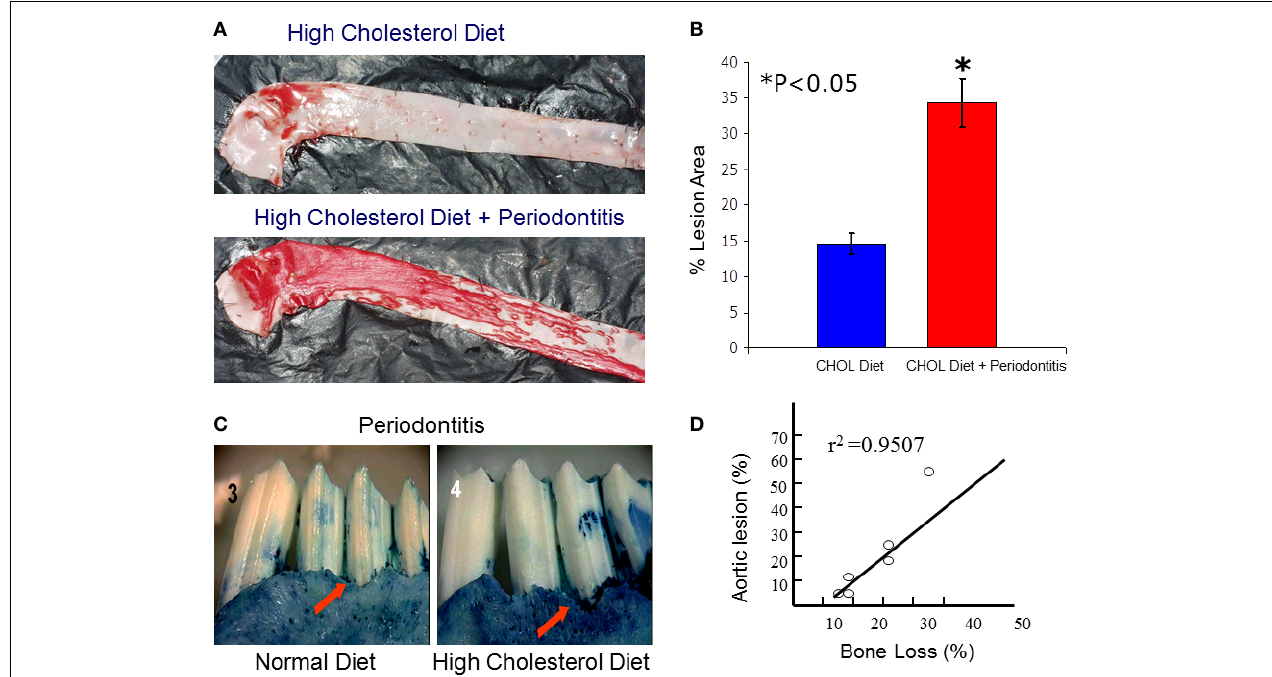
dramatically more and extended level of lipid depositions covering almost entire surfaces of thoracic and abdominal aortas. (B) Quantification of lipid covered area clearly showed that local periodontal inflammation significantly increases the atherosclerotic changes induced by cholesterol diet. (C) Periodontal disease was also more dramatic in those rabbits received high cholesterol diet suggesting a reciprocal relationship between local and systemic inflammations. (D) The severity of bone loss was positively correlated with degree of the fatty streaks (lipid depositions; r 2 =